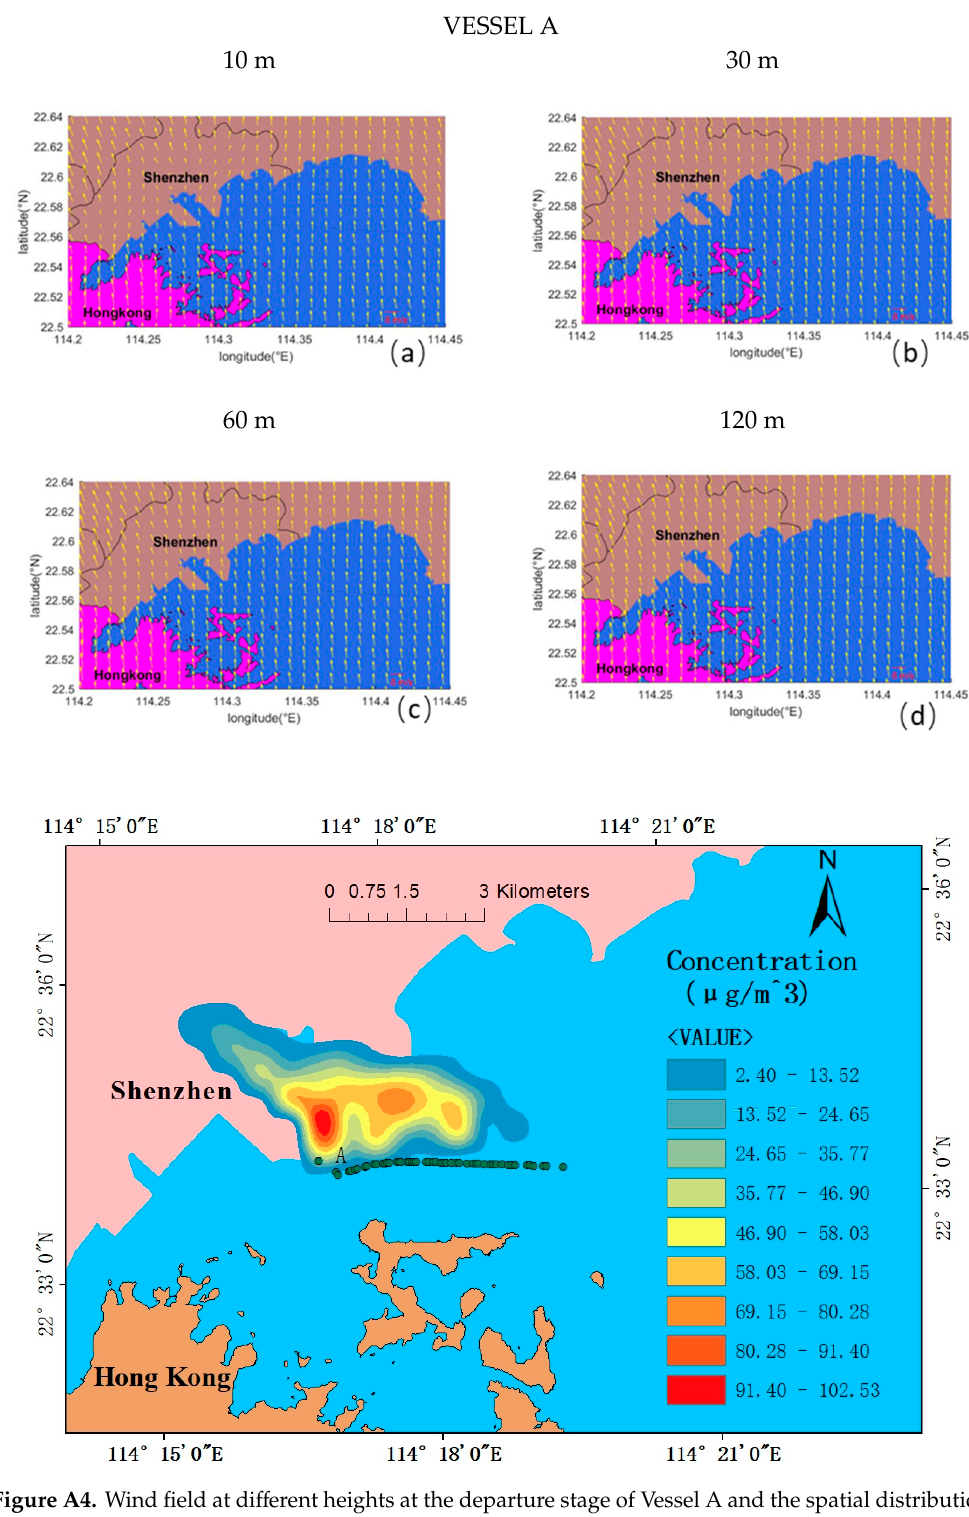
Figure A4. Wind field at different heights at the departure stage of Vessel A and the spatial distribution of the maximum concentration of each simulation grid during the simulation period. ( a ) 10m, ( b ) 30m, ( c ) 60m and ( d ) 120m.